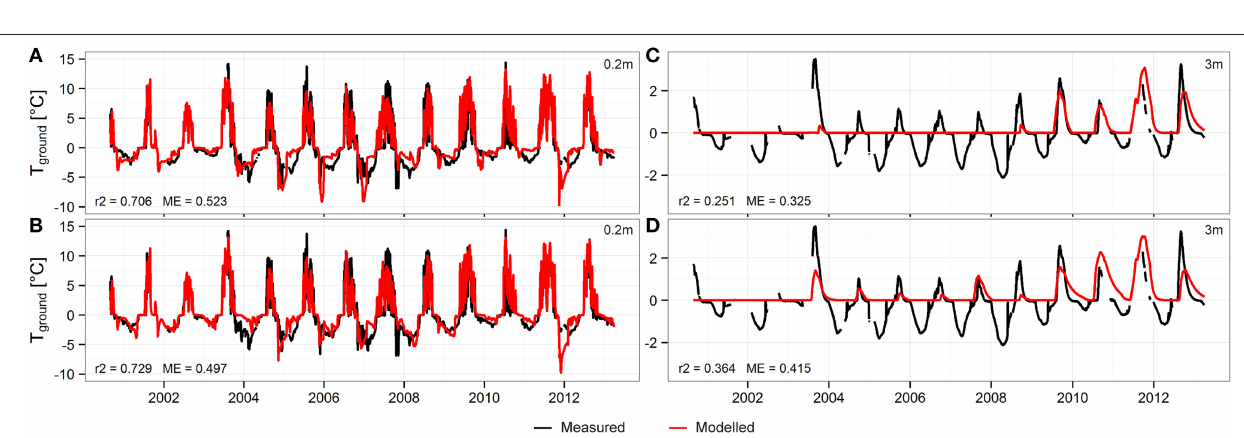
Similarly, at 3 m depth r 2 = 0.251 before finer tuning and r 2 = 0.364